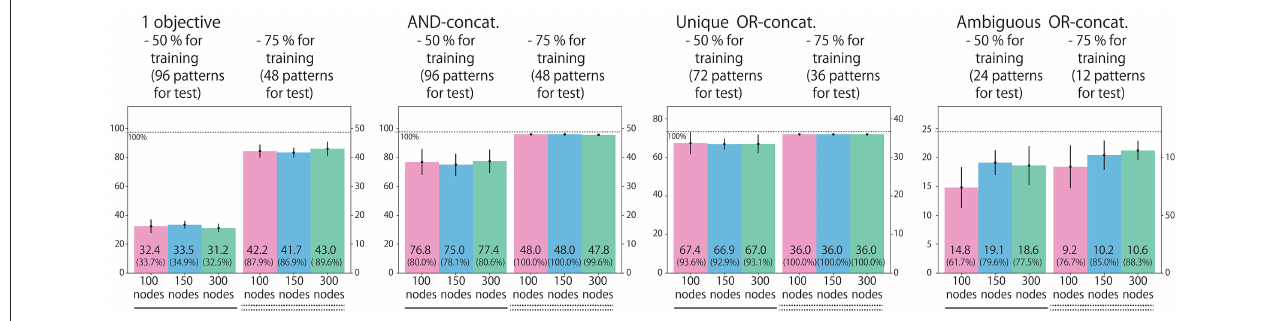
FIGURE 10 | To evaluate the model’s generalization ability for the flag task, we conducted learning experiments again by removing (a) 50% or (b) 25% of the possible situations from training dataset. We evaluated the performance by counting how many unexperienced situation patterns each model dealt with appropriately. Similarly to Figure 4 , we evaluated the performances with respect to each of the four situation